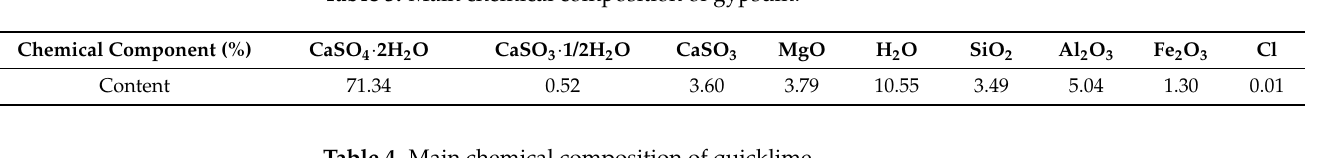
Table 3. Main chemical composition of gypsum.